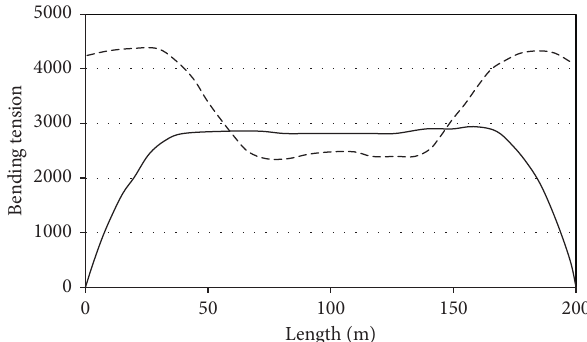
Figure 9: Variation in the extent of maximum axial tensions along the pipeline with different final